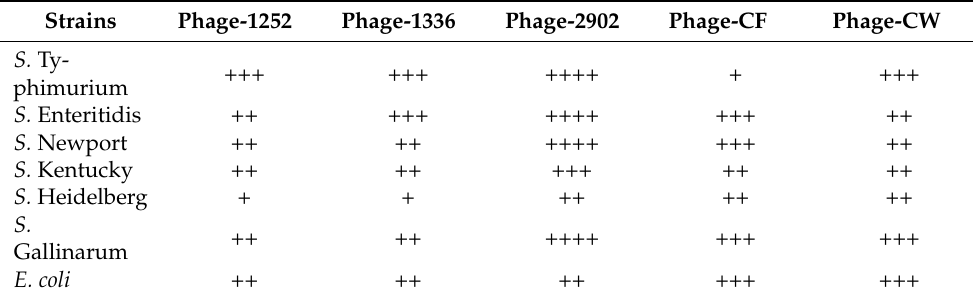
(Table S1). The host range spot test for these phages was further tested by using different Salmonella serovars and enterohaemorrhagic E. coli (Tables 1 and 2) as BHC. A total of eight phage candidates were purified and isolated from the initial 20 phages, including phage-2902 (Table 2). The efficiency of the lytic activity of these phages was measured against six serovars of Salmonella , including S. Typhimurium, S. Enteritidis, S. Newport, system and visual assessment of plaques on the spot test. The isolated phages were purified by six generations of purification. Table 2. Lytic activity of isolated phages against selected bacterial hosts.